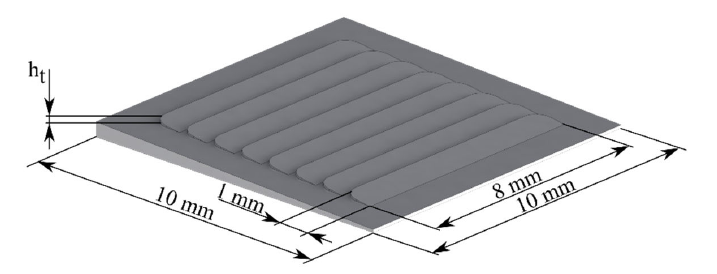
Figure 3. Dimensions of the textured lubrication gap.